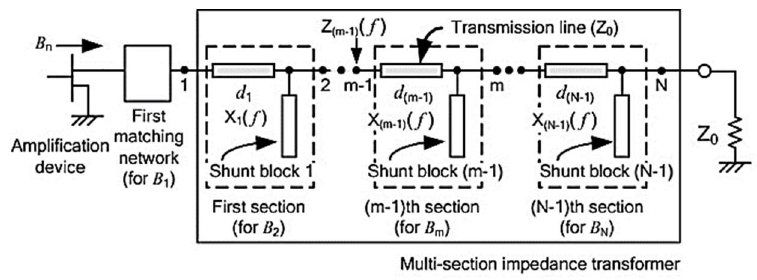
Figure 19. Basic topology of multi-section multi-band matching network [104].